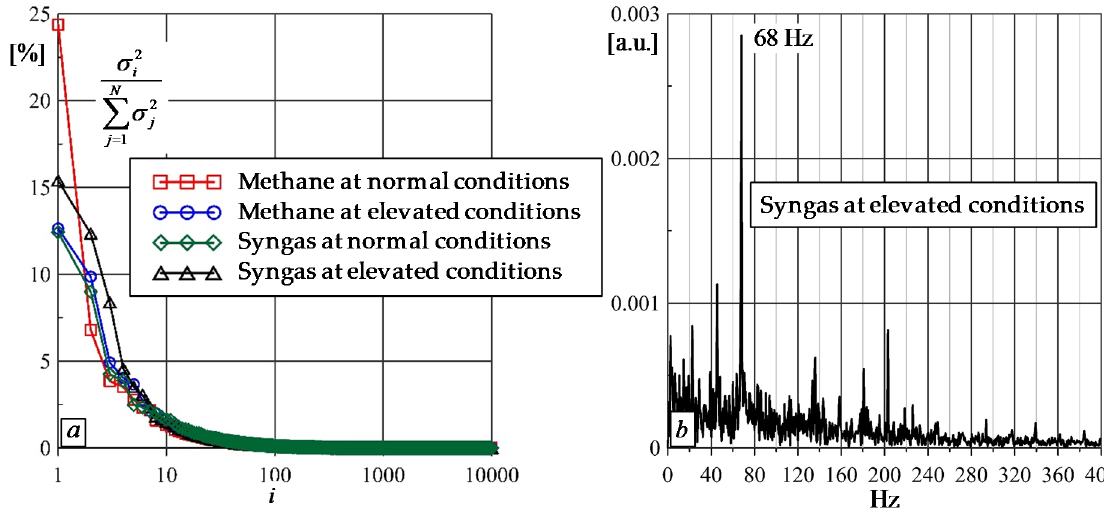
Figure 14. PCA spectra of OH* images ( a ) and spectrum of the temporal coefficient of the first mode for the syngas flame at elevated pressure ( b ).